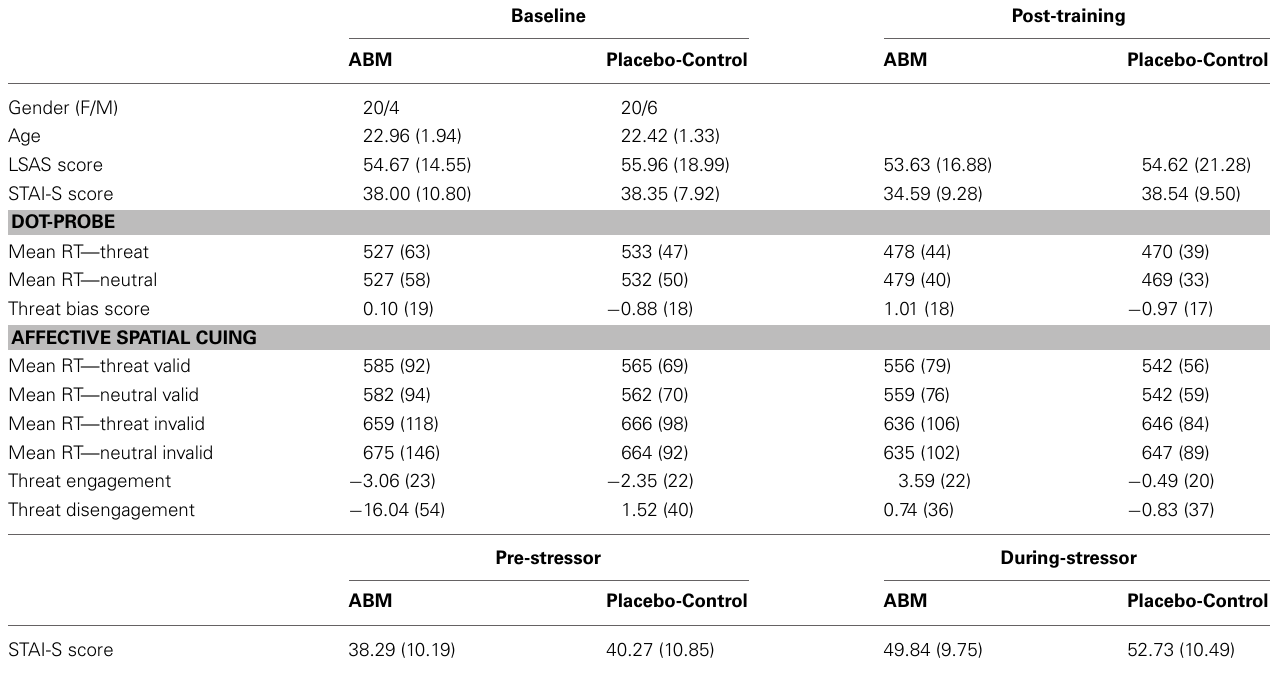
Table 1 | Means and SDs of baseline, post-training, pre-stressor, and during-stressor measurements by group ∗